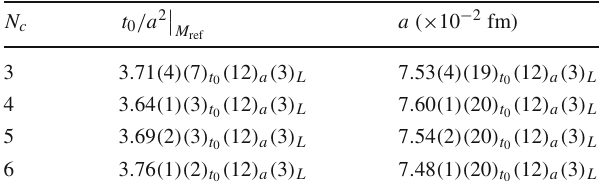
(cid:18) (cid:18) Table 2 Results for the t 0 / a 2 and the lattice spacing as a function M ref of N c . The first error is statistical, the second comes from the uncer- tainty in t 0 in physical units, the third stems from the difference in the definitions of E ( t ) after improvement, and the fourth are finite volume effects estimated from Ref.